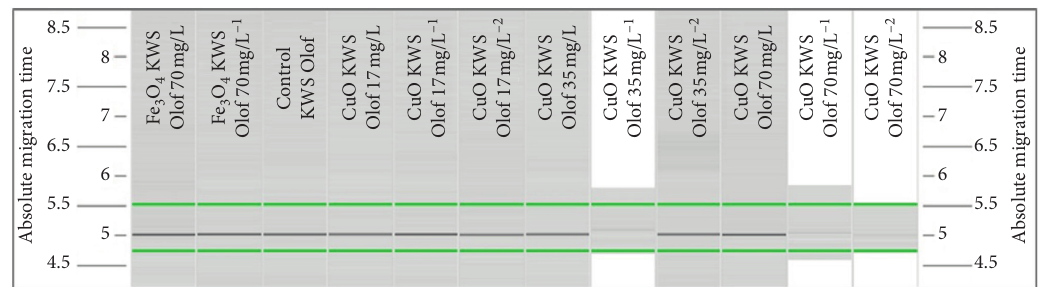
Figure 4: Examples of the RAPD profile of genomic DNA isolated from barley “KWS Olof” variety treated with Fe